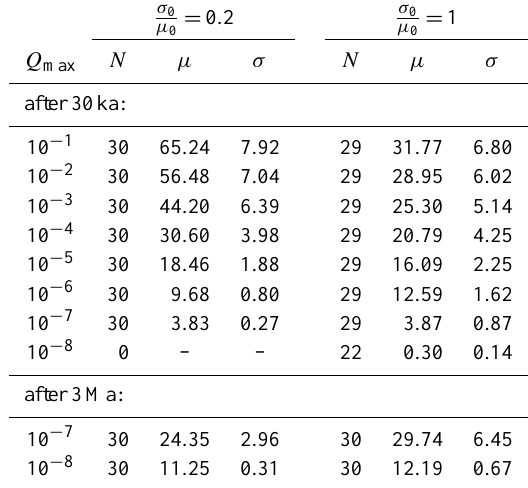
Table 2. Statistical values of the percentage of large-aperture tubes with a ≥ 0 . 01m after fixed genesis times for different maximum recharge rates Q max ( m 3 s − 1 ) and both degrees of initial heterogeneity σ 0 . N gives the number of realisations from which µ 0 the mean percentage µ and the corresponding standard deviation σ are calculated. Realisations in which nary a tube reached the given size range are excluded. σ 0 = 0 . µ 0